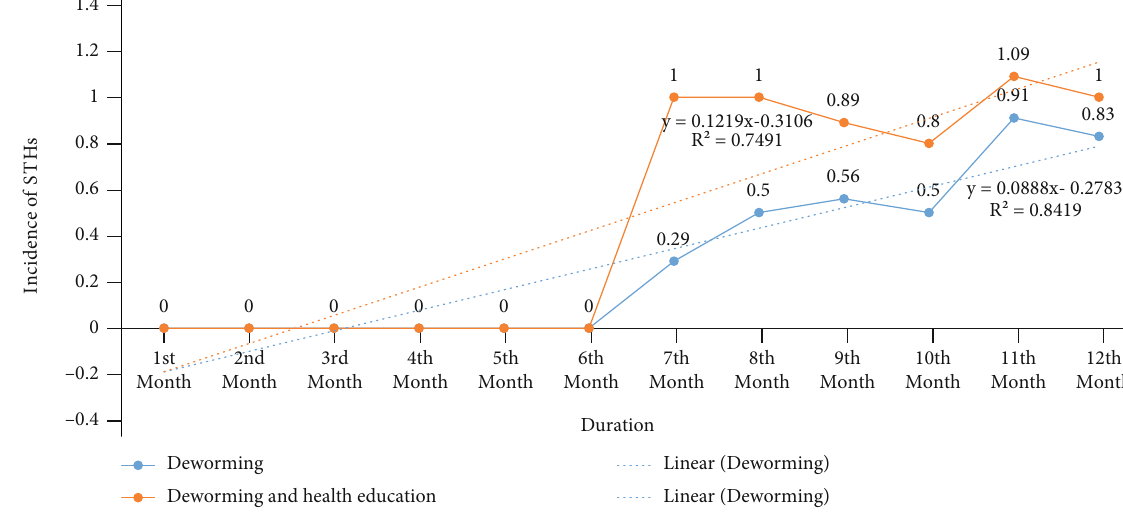
Figure 4: Monthly incidence of STHs in DO and DHE schools in Kogi East, Nigeria. Table 4: Incidence of STHs during follow-up at 12 th , 24 th , 36 th , and 48 th weeks for both interventions.